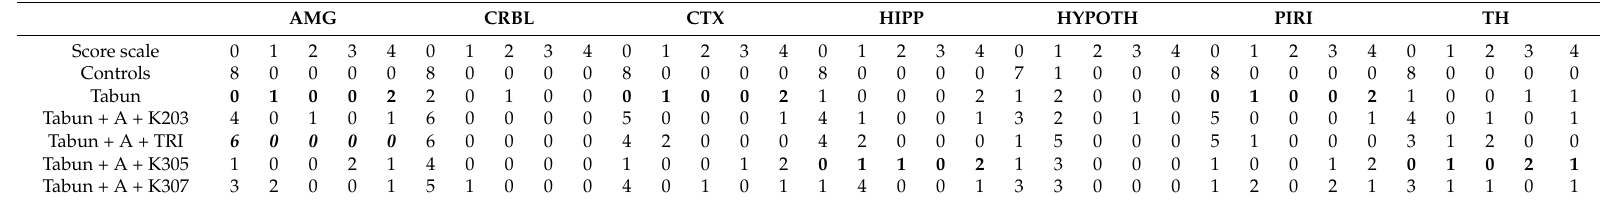
Table 5. Score of tabun-induced degeneration (Fluoro-Jade ® C positivity) in rat brain and its modulation by different therapeutic approaches. AMG CRBL CTX HIPP HYPOTH PIRI TH Score